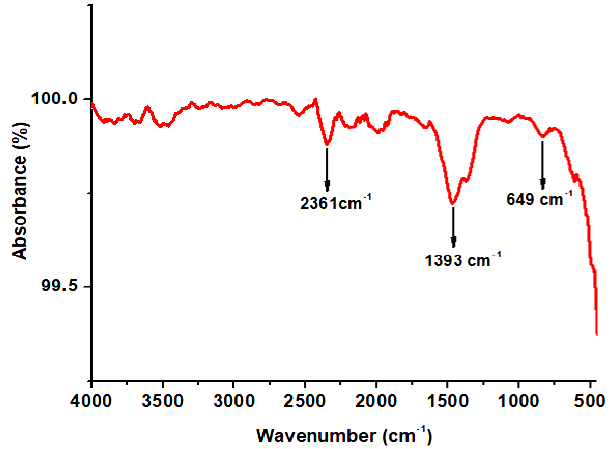
Figure 4. FTIR spectra of the La 2 ZnO 4 nanocomposite.